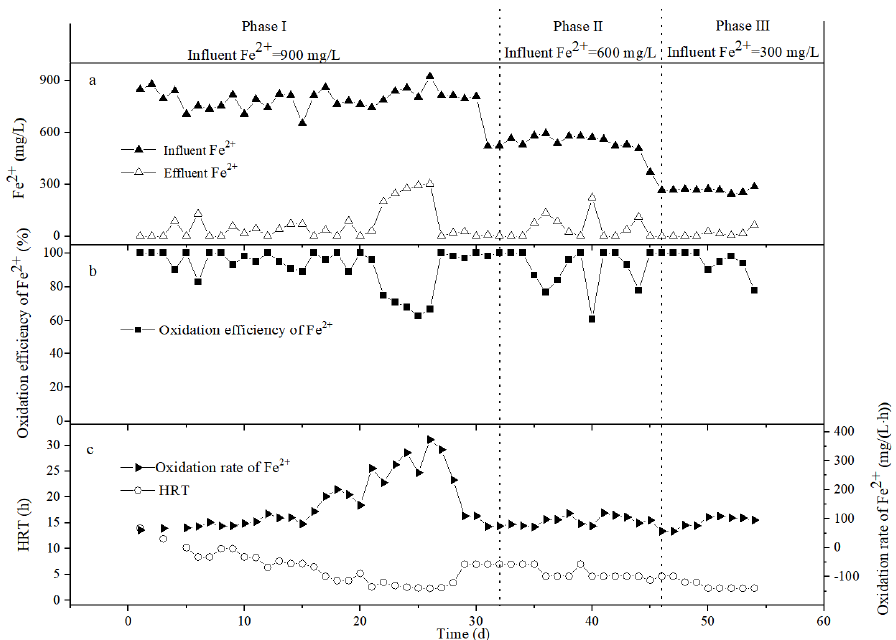
Figure 4. Variation of the Fe 2+ concentration ( a ), Fe 2+ oxidation efficiency ( b ), Fe 2+ oxidation rate, and HRT ( c ) in the influent and effluent of the bio-volcanic rock packed column. and HRT ( c ) in the influent and effluent of the bio-volcanic rock packed